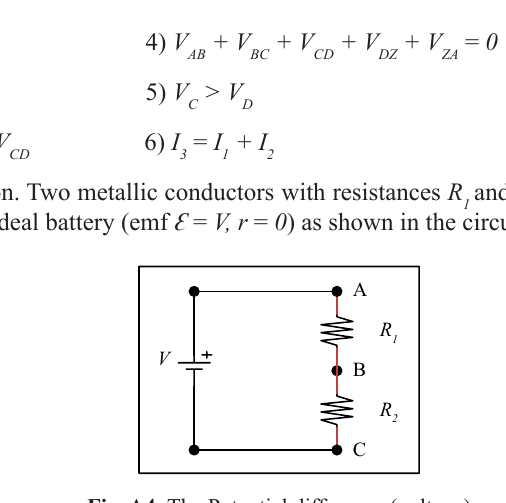
Fig. A3. The current and the voltage in a simple electric dc circuit